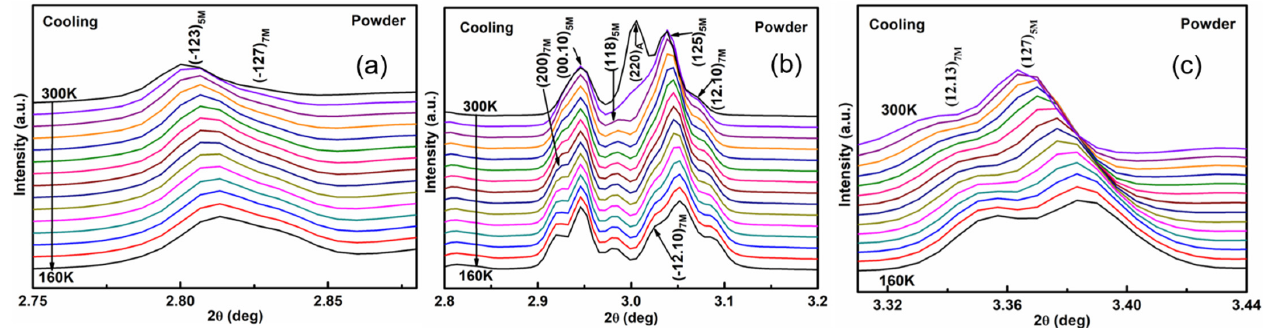
Figure 5. High-energy X-ray diffraction patterns around 2 θ = 2.8° ( a ), 2 θ = 3.0° ( b ), and 2 θ = 3.4° ( c ) collected during cooling from 300 K to 160 K for the Ga22-4 ( x = 5.5) alloy.